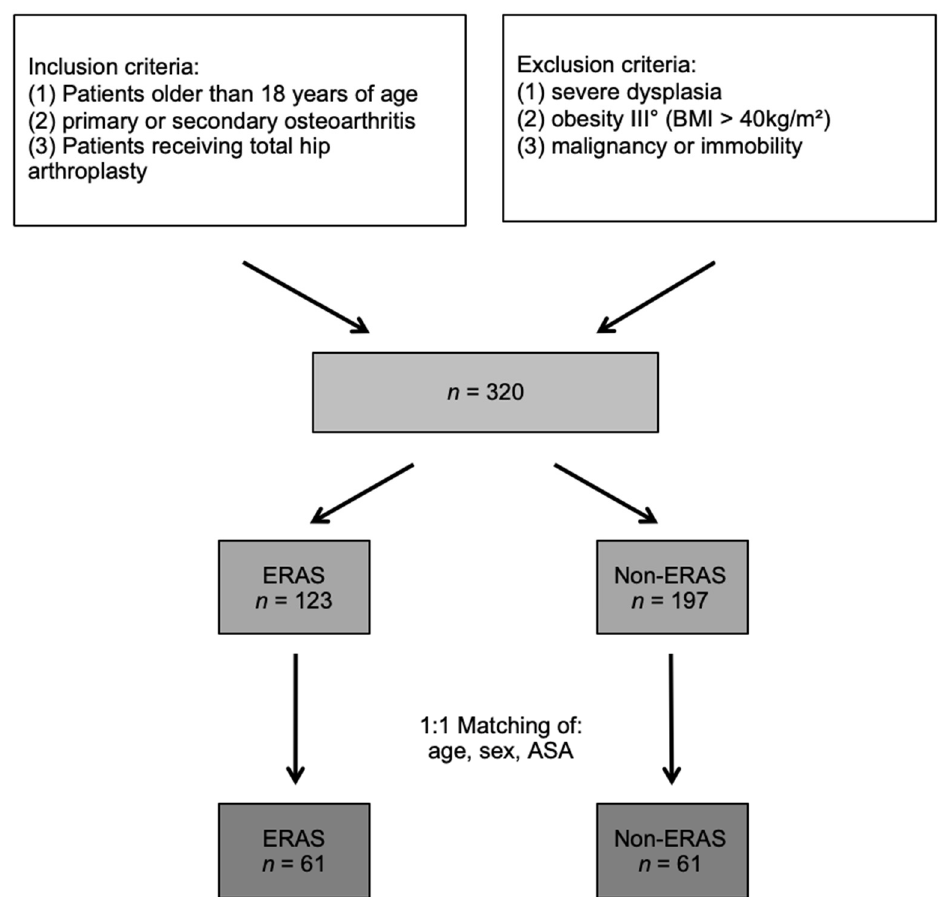
Figure 1. Flowchart: Enrollment and matched pair method of the study group.